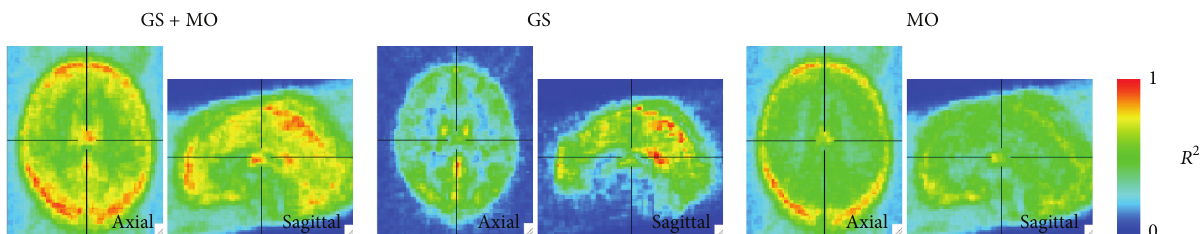
Figure 5: Marginal explained variances ( 𝑅 2 values) of the regressors in nuisance removal regression models GS + MO. The labels GS and MO correspond to global signal and motion regressors,